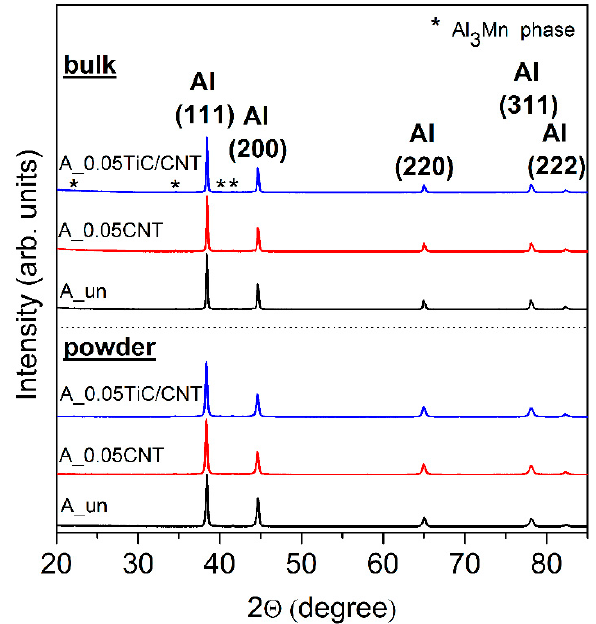
Figure 5. XRD patterns of powders and bulk materials: A_un, A_0.05CNT and A_0.05TiC/CNT.